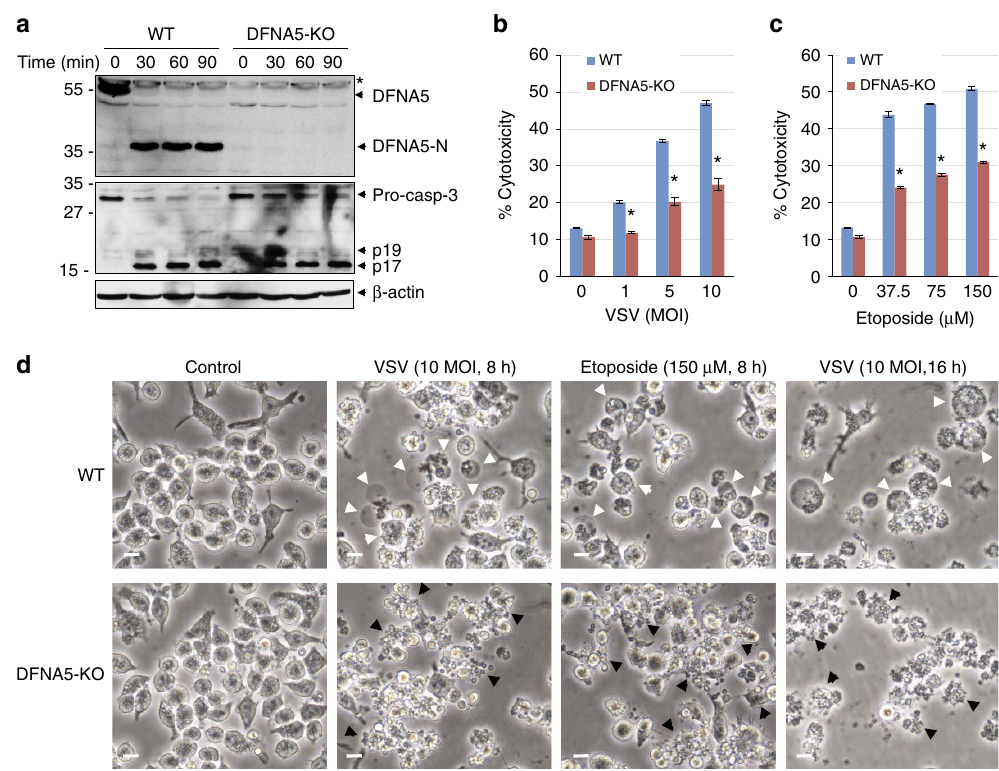
Figure 8 | Knockout of DFNA5 reduces secondary necrosis in macrophages. ( a ) Immunoblots of S100 lysates from DFNA5 þ / þ (WT) and DFNA5 (cid:2) / (cid:2) (DFNA5-KO) macrophages stimulated with cytochrome c for the indicated times at 37 (cid:2) C. The blots were probed with anti-DFNA5 (upper), anti-caspase-3 (middle) or anti- b -actin (lower) antibodies. Asterisk indicate non-specific band (NS). ( b , c ) Cytotoxicity of VSV ( b ) ( n ¼ 3) and etoposide ( c ) ( n ¼ 3) as measured by LDH release in the culture supernatants of DFNA5 þ / þ (WT) and DFNA5 (cid:2) / (cid:2) (DFNA5-KO) macrophages infected with VSV or treated with etoposide for 8h. * P o 0.0001, Student’s t -test. ( d ) Microscopic images of DFNA5 þ / þ (WT) and DFNA5 (cid:2) / (cid:2) (DFNA5-KO) macrophages infected with VSV or treated with etoposide as indicated. White arrowheads indicate ballooning necrotic cells, and black arrowheads indicate blebbing apoptotic cells. Scale bar, 20 m m. Results are representative of at least three independent experiments. Error bars represent standard error of the mean